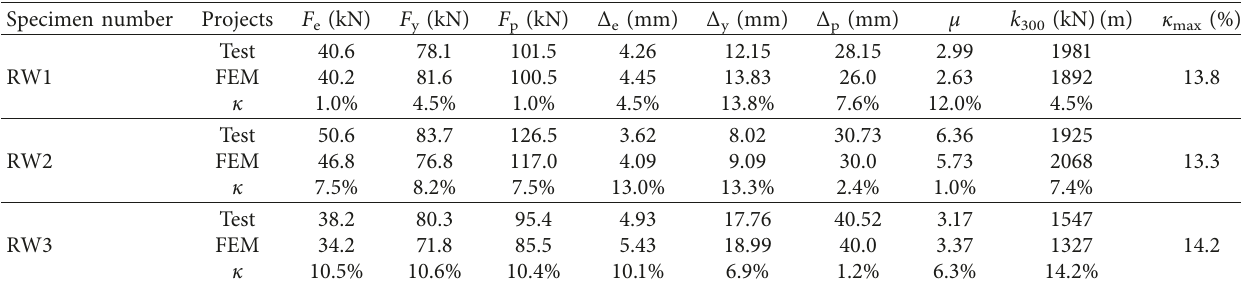
Figure 5: Comparisons of load-displacement curves. (a) Specimen RW1. (b) Specimen RW2. (c) Specimen RW3. (d) 1 st floor of specimen MRW1. (e) 2 nd floor of specimen MRW1. (f) 1 st floor of specimen MRW2. (g) 2 nd floor of specimen MRW2. (h) 1 st floor of specimen MRW3. (i) 2 nd floor of specimen MRW3. Table 4: Comparisons between the simulated and test results